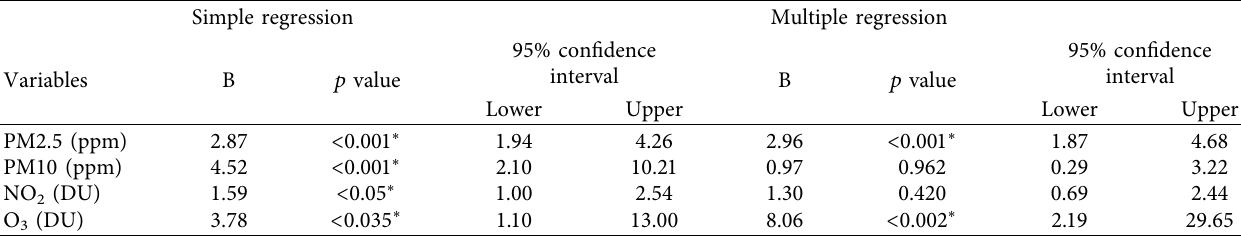
Table 3: Te linear and multiple regression analysis between PM-2.5, PM-10, NO countries.